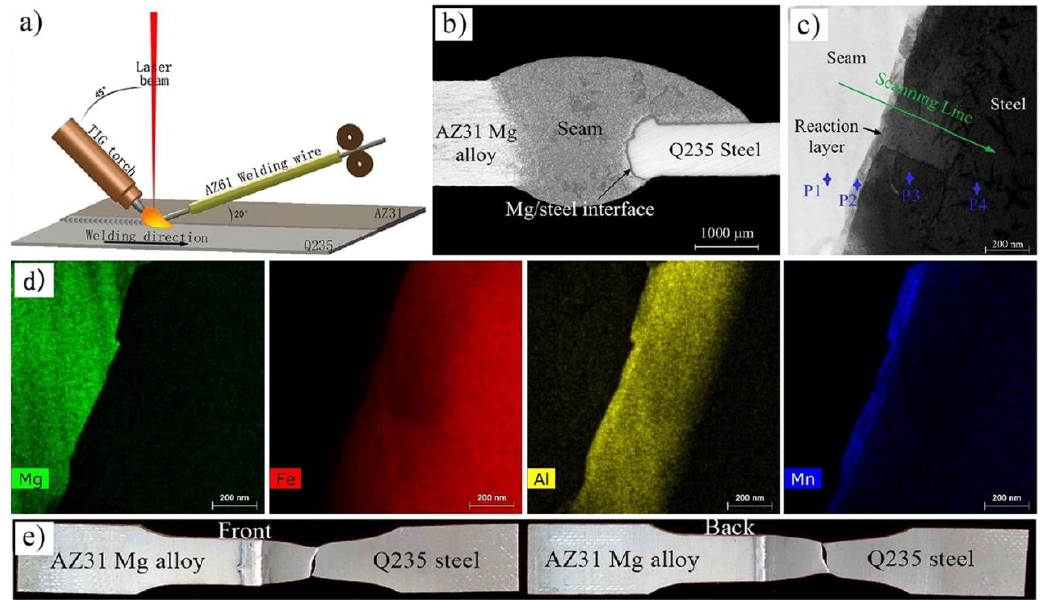
Figure 23. Laser-TIG hybrid welding with filler wire [83] ( a ) schematic diagram of welding; ( b ) cross-section appearance for 850 W; ( c ) STEM micrograph taken from the interface of Mg/steel joint; ( d ) elemental distribution of Mg, Fe, Al, Mn; ( e ) fracture location of joint.